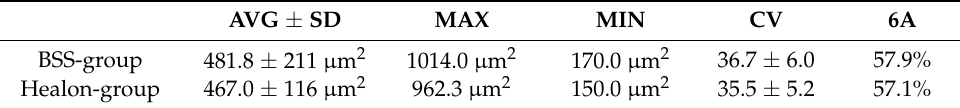
Table 2. The first postoperative day endothelial cell area pattern and